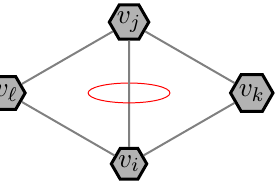
Fig. 5. The cylinder between v i and v j needs to fit through the boundary between their Voronoi cells, which runs between the centroids of (cid:52) v i v j v k and (cid:52) v i v j v (cid:96) .